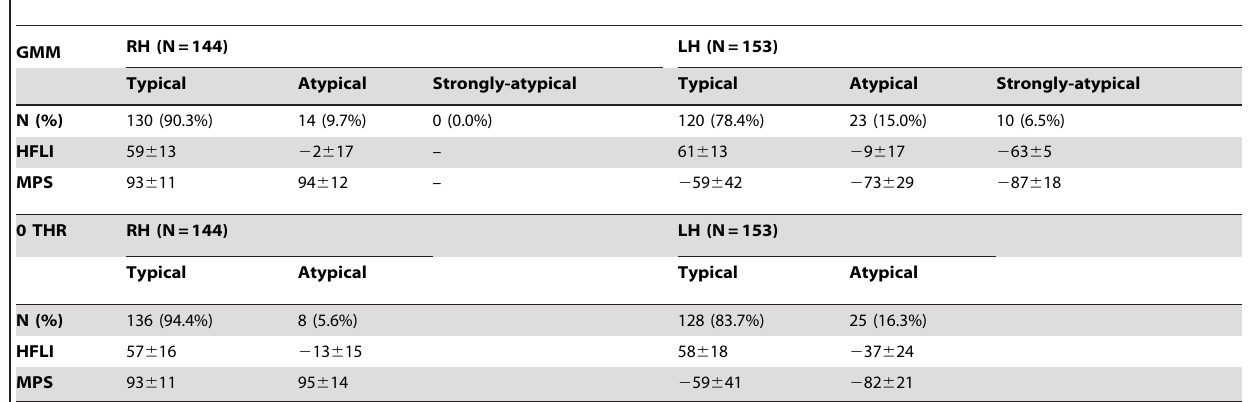
Table 5. Characteristics of language lateralization subjects in the RH and LH subgroups depending on their type of language lateralization using Gaussian mixture modeling (GMM, top) or a classical 2-category based on a zero threshold on HFLI values (0 THR,